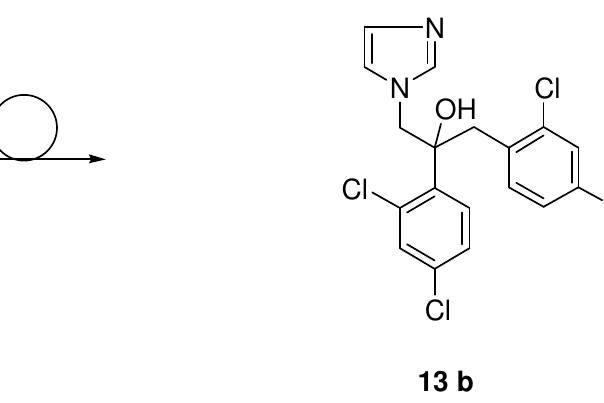
Figure 7. From miconazole to imidazolyl carbinols with antifungal